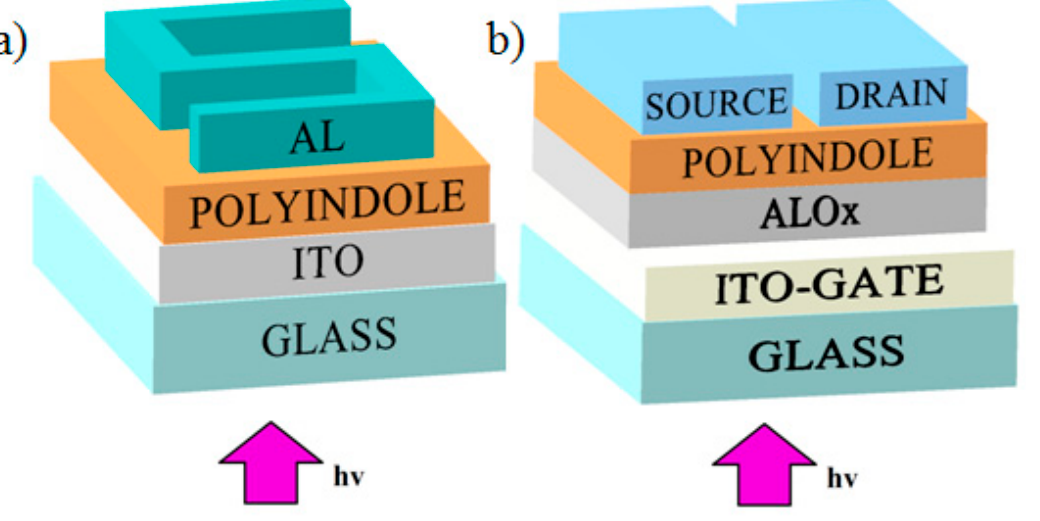
Figure 2. The structure of ( a ) a photoresistor and ( b )